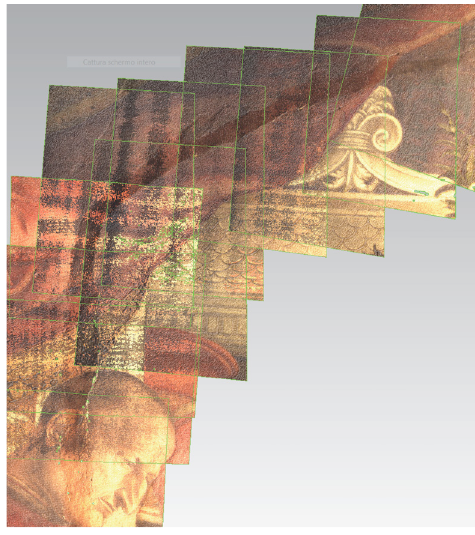
Figure 11. Detail of meshes acquired along the